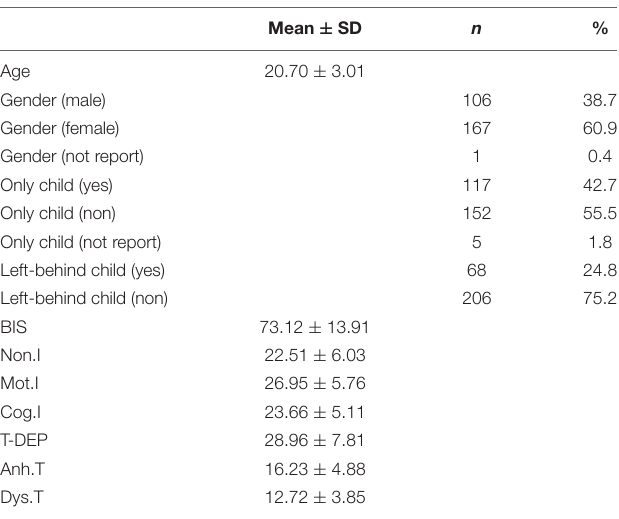
TABLE 1 | Demographic information and descriptive